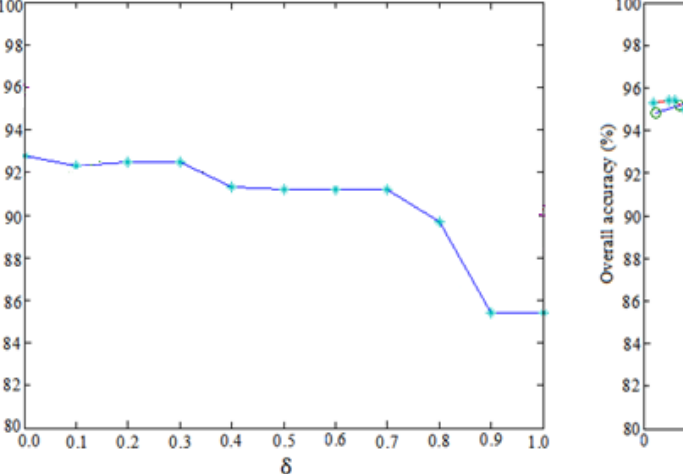
Figure 2. The sensitivity analysis of parameter